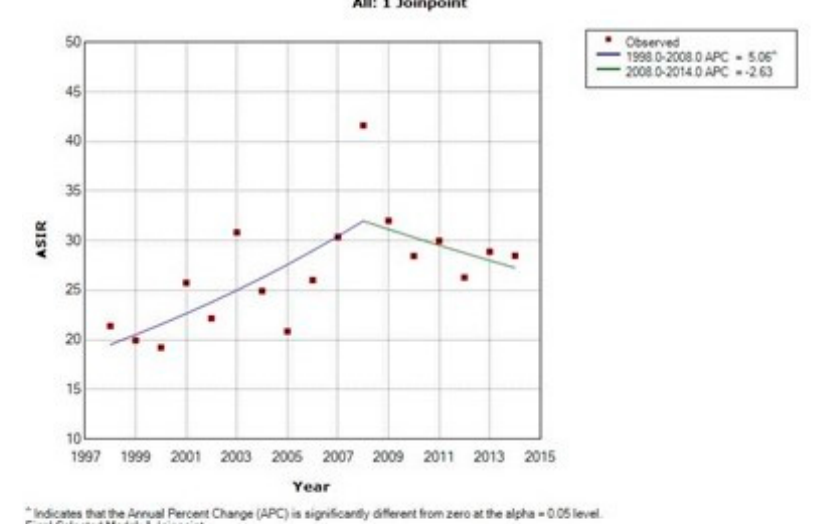
Figure 4. Time trends of age-standardized incidence rates of squamous cell carcinoma of cervix uteri, Cluj County, 1998–2014.